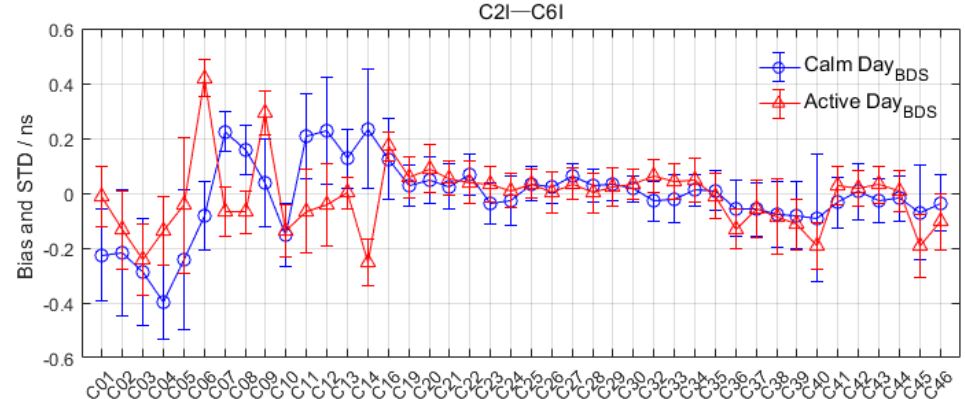
Figure 18. Comparison results between DCB and CAS products of BDS satellite.